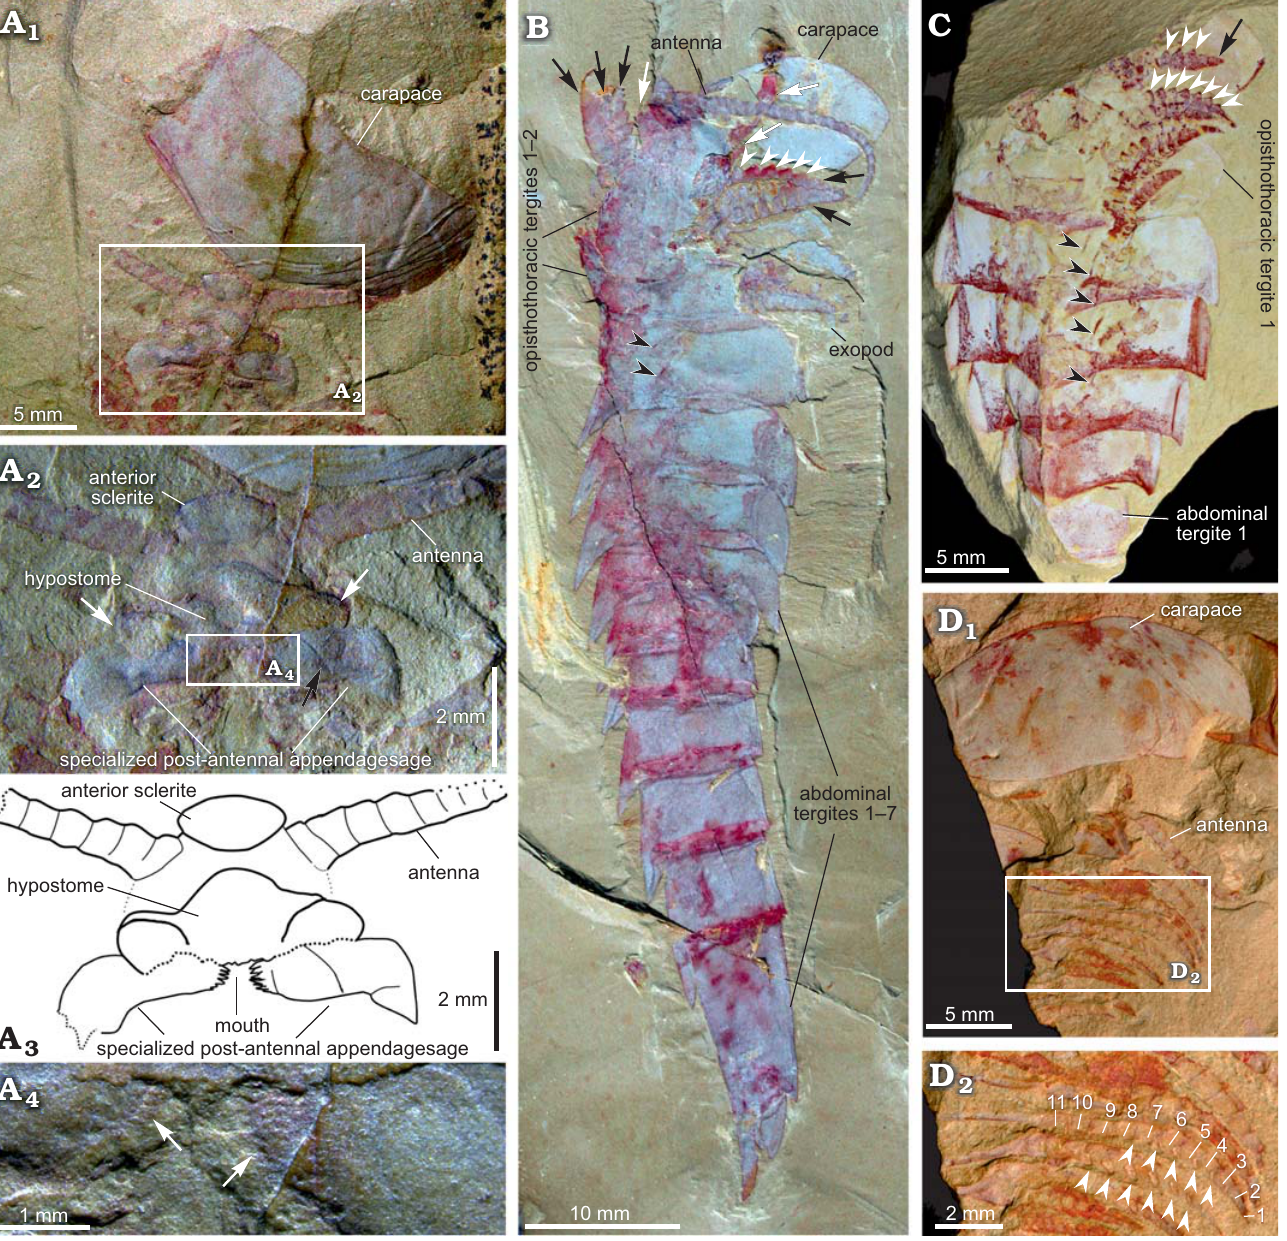
Fig. 4. Carapace and appendages of fuxianhuiid arthropod Guangweicaris spinatus Luo, Fu and Hu, 2007 from the lower Cambrian Guanshan Biota, China. A . YKLP 11201, detached carapace in ventral view and the organization of head appendages (A 1 ); close-up of the head appendages (A 2 , photograph; A 3 , ex- planatory drawing); white arrows, the lateral lobes of the hypostome; black arrow, the possible section in SPA; close-up of the spinose medial margin of the SPA (A 4 ), white arrows indicate the spinose medial margin. B . NIGPAS Kgs-1-137, nearly complete body with well-preserved appendages in lateral view; white arrows, the anterior appendages; black arrows, the appendages belonging to the first and second opisthothoracic segments; white arrowheads, lateral subpentagonal spines of an endopod; black arrowheads, the attachments of the proximal podomeres of appendages. C . YKLP 11202, opisthothoracic append- ages in dorsal view; black arrow, the terminal subtriangular podomere; white arrowheads, lateral subpentagonal spines of an endopod; black arrowheads, the attachments of the proximal podomeres of appendages. D . NIGPAS Kgs-6-108 the carapace, antennae and trunk appendages in ventral view (D 1 ), close-up of trunk appendages showing 11 podomeres in the endopod of one biramous appendage (D 2 ), arrowheads point to hollow nodes that indicate the insertions of the spines along the inner margin of the endopod. Images B, C courtesy of Shixue Hu (Chengdu Centre of the Geological Survey of China, Chengdu, ing a medial, subpentagonal spine (Fig. 4B, C, white arrow- heads). The distal podomere, by contrast, is in subtriangular shape and without a spine (Fig. 4C, black arrow). Due to dif- ferent angles of compression, nodes instead of spines are ob- served in other specimens (Fig. 4D , white arrowheads). The 2